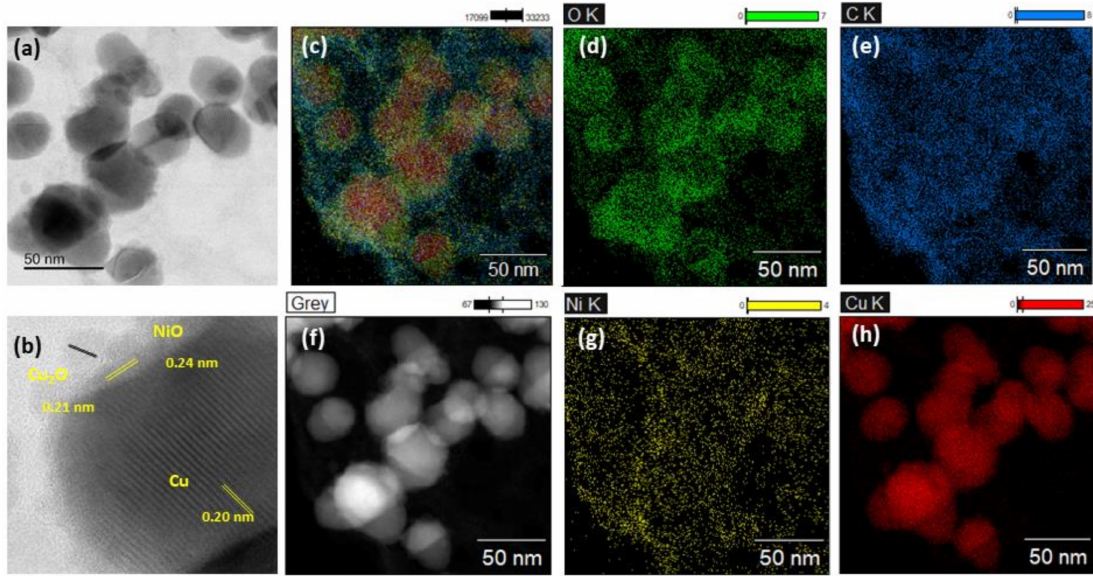
Figure 3. ( a , b , f ) HAADF–STEM images with different resolutions. ( c , d , e , g , h ) The corresponding elemental mapping results of the C–NiCu–MOF